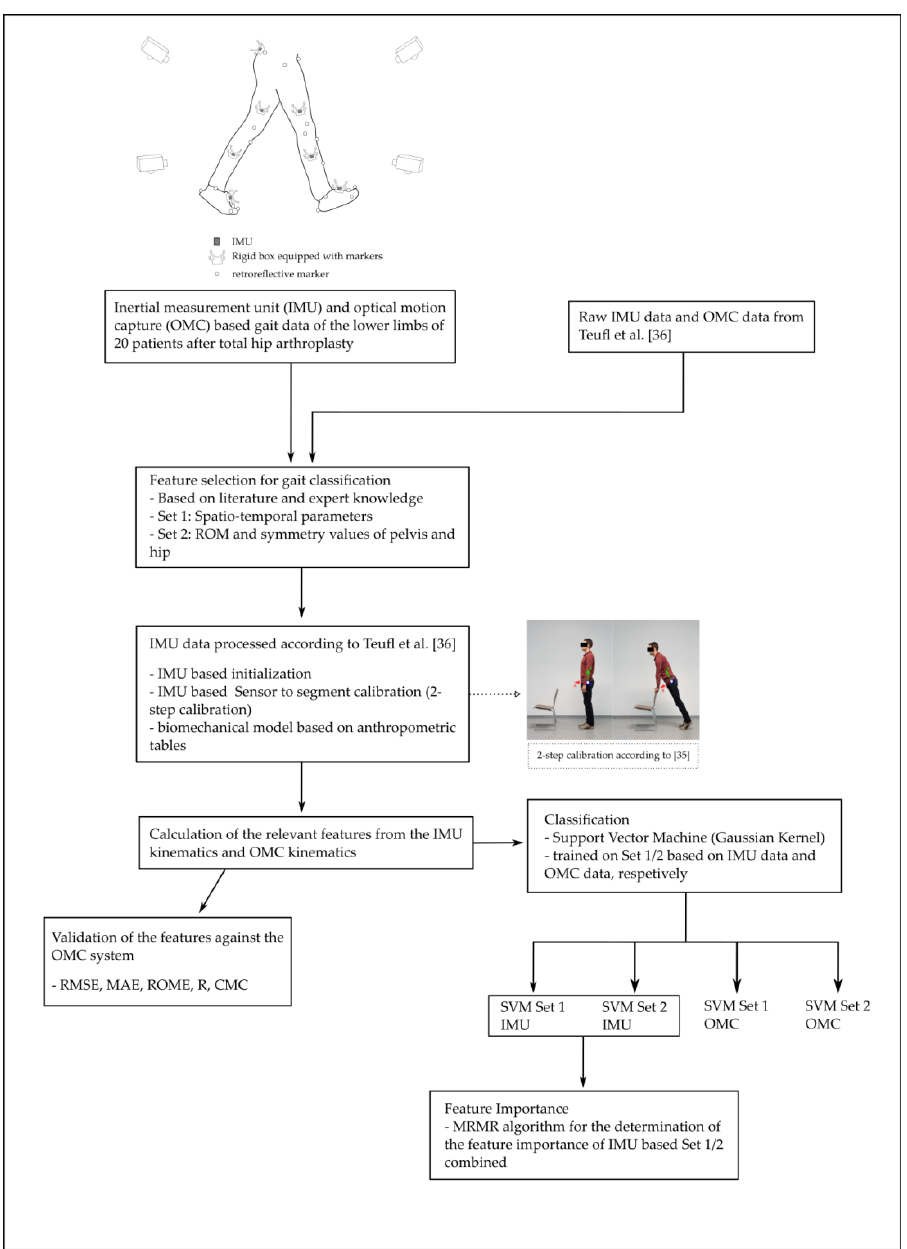
Figure 3. Workflow of the present study.